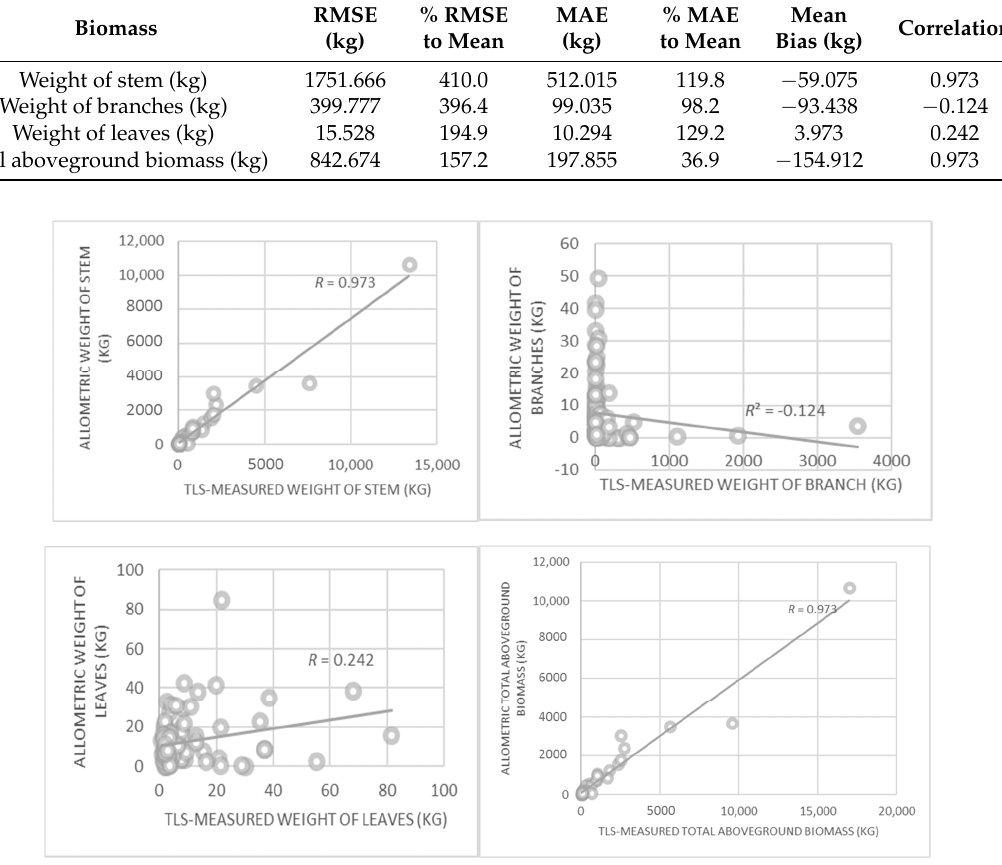
Figure 10. Correlation between total aboveground biomass, Weight of Stem, Weight of Branches and Weight of Leaves estimated using allometric equations and those determined using TLS-derived values. Table 3. Comparison of total above ground biomass (TAGB) and weight of stem, branches and leaves for all tree species between TLS ‐ measured values and values obtained from allometric equations.